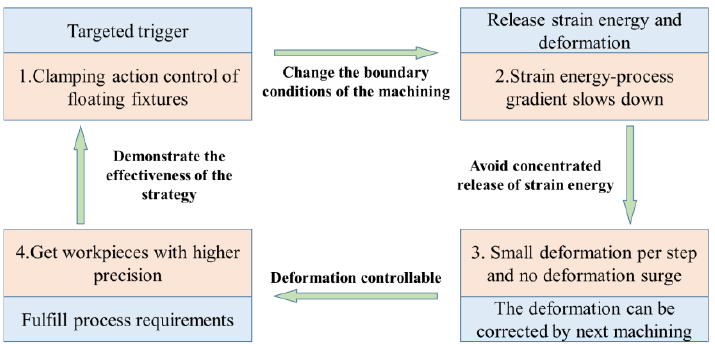
Figure 1. Principle of clamping action control based on gradient control of strain energy.